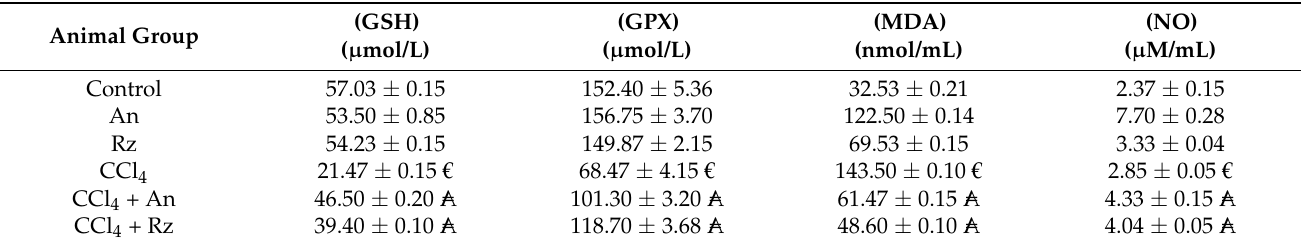
Table 7. Ameliorative effects of An or Rz administration on the serum levels of nitrosative and antioxidant enzymes in different experimental groups following CCl 4 -induced